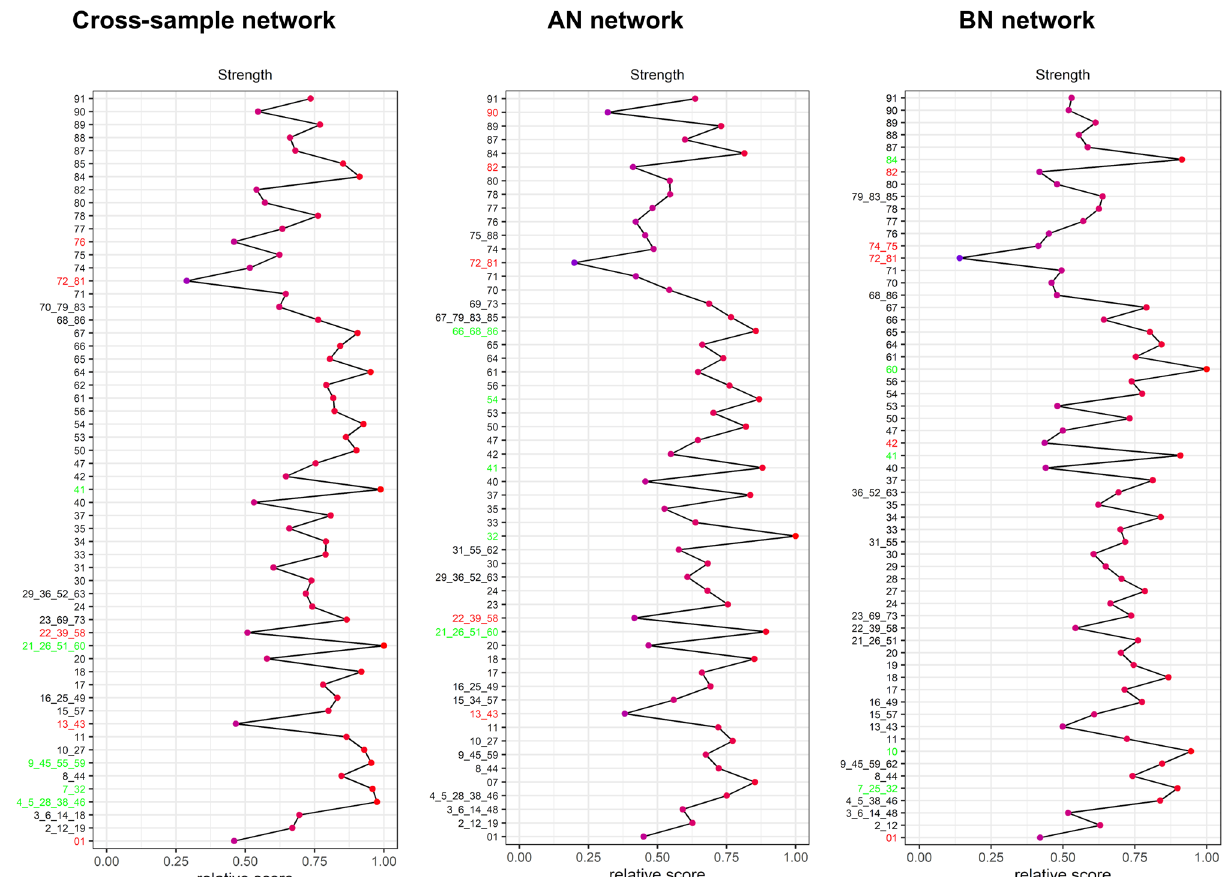
Figure 4. Plots of the strength centrality indices of all items of the (non-redundant) EDI-3 scale, estimated for each of the networks under study (cross-sample, AN, and BN). Nodes in green correspond to the five strongest ones in the corresponding network, whereas the red nodes indicate those with the lowest strength centrality